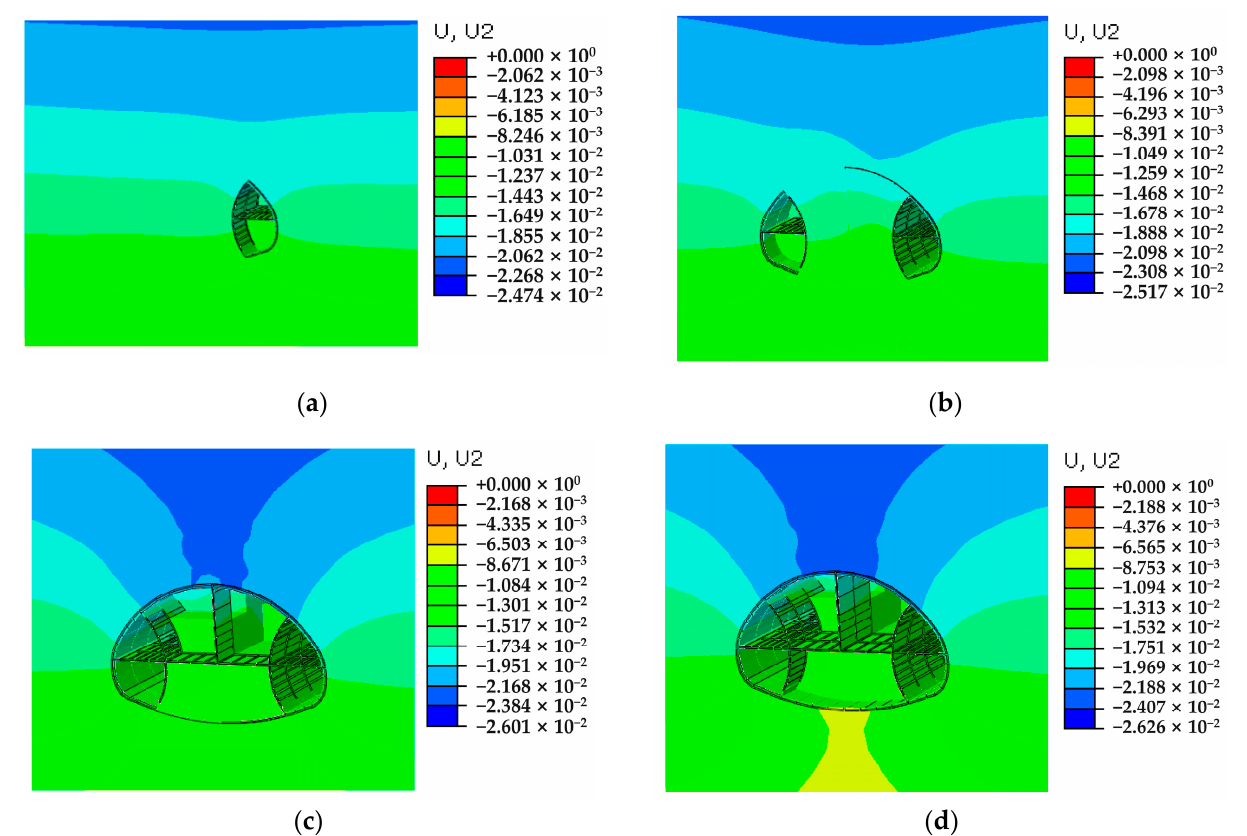
Figure 5. Vertical displacement of surrounding rock at the target section of rock mass part excavation under Condition 1 (unit: m): ( a ) Excavation of the right pilot tunnel; ( b ) Excavation of the left pilot tunnel; ( c ) Excavation of the upper part of the middle pilot tunnel; ( d ) Excavation of the lower part of the middle pilot tunnel.